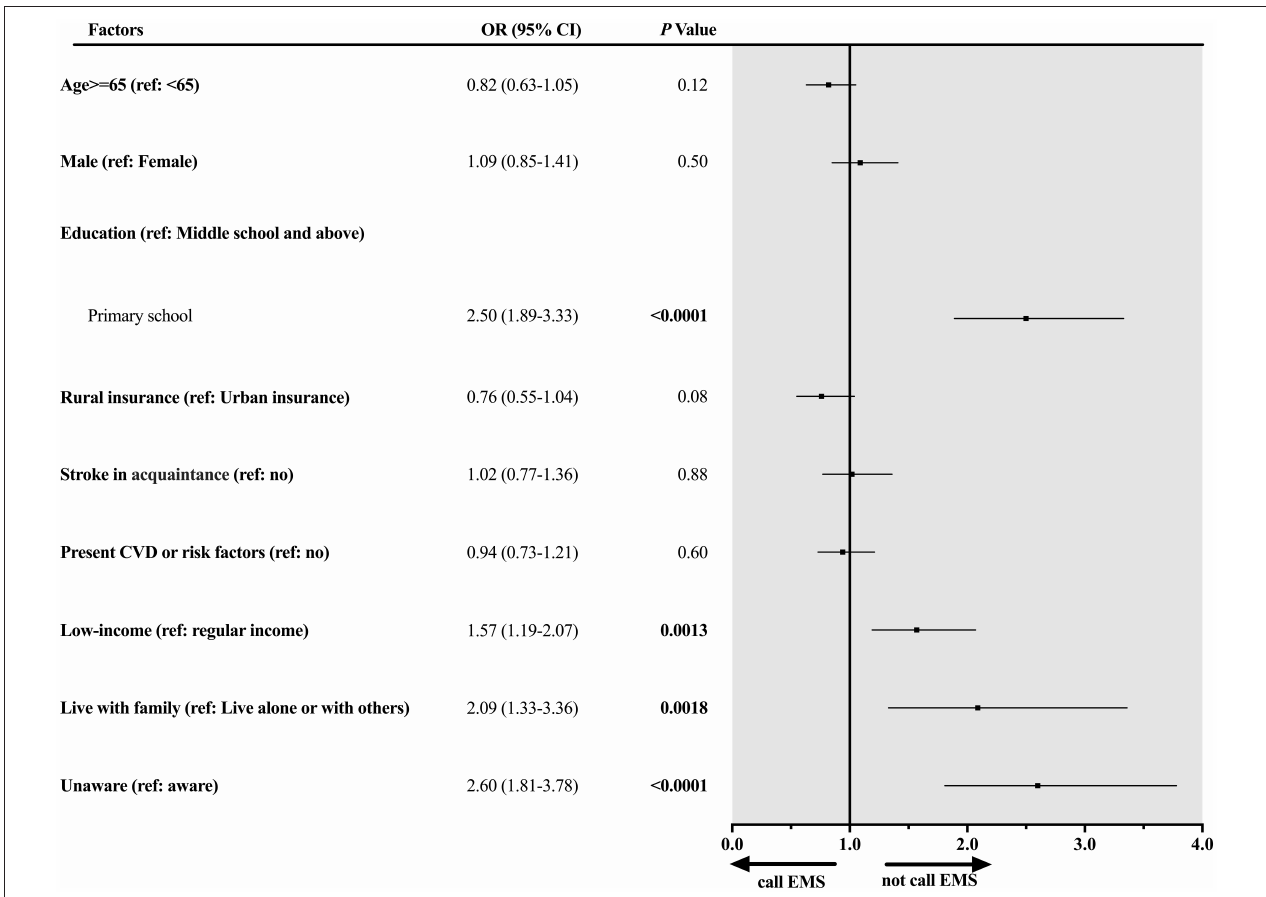
FIGURE 3 | Factors associated with not calling EMS among rural participants with previous TIA. Forest plot and corresponding statistical results (OR, 95% CI, and p- value) illustrate risk factors associated with not calling EMS among rural participants with previous TIA.